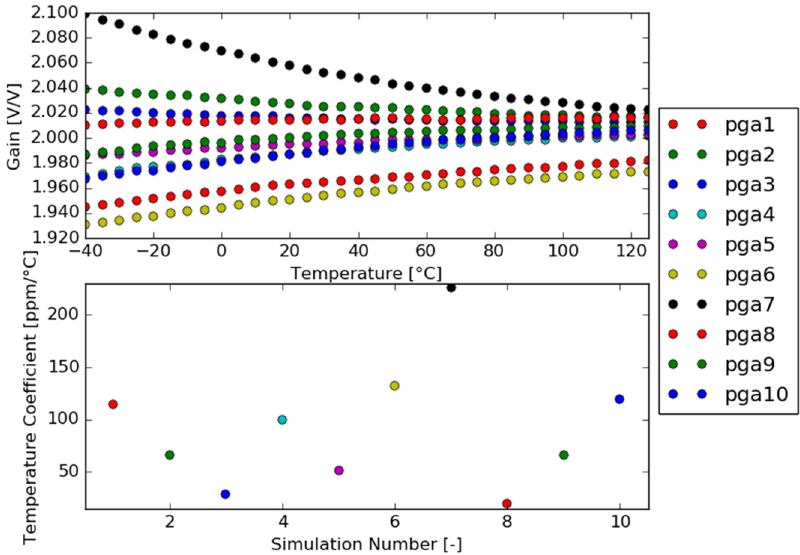
Figure 22. PGA gain against temperature. Table 6. Experimental temperature coefficients of PGA.